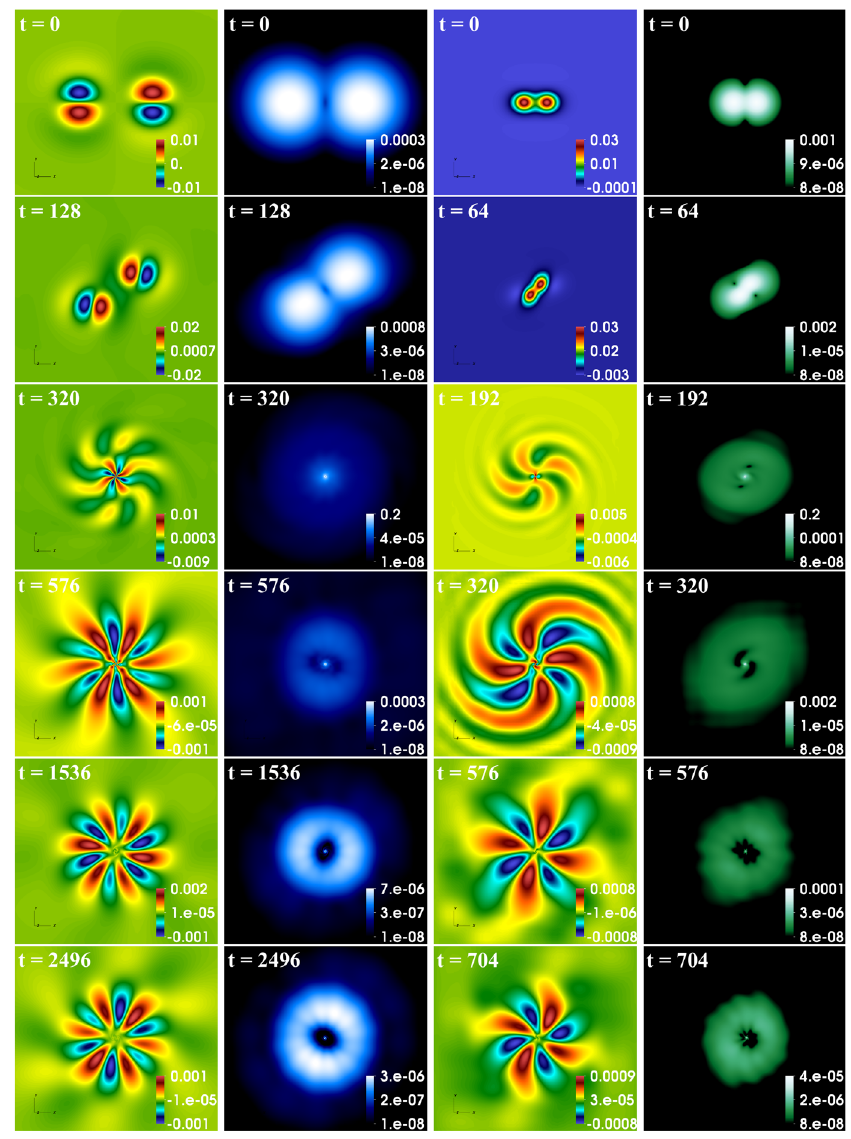
Fig. 29 Mergers of orbiting, non-spinning: Proca stars (left two columns) and scalar boson stars (right two columns). Snapshots along the equator show: (leftmost) the real part of the scalar Proca potential, X / , (middle left) Proca energy density, (middle right) the real part of the scalar fi eld, / , (rightmost) the scalar energy density. These evolutions suggest that mergers result in a BH synchronized with an m ¼ 6 Proca cloud or an m ¼ 4 scalar cloud, respectively. Reproduced with permission from Sanchis-Gual et al. (2020), copyright by